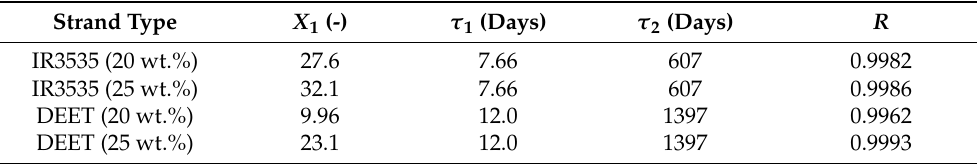
Table 3. Parameter for the desorption model of Equation (3) obtained by nonlinear least squares regression for release data obtained for PLA-repellent aged at 50 ◦